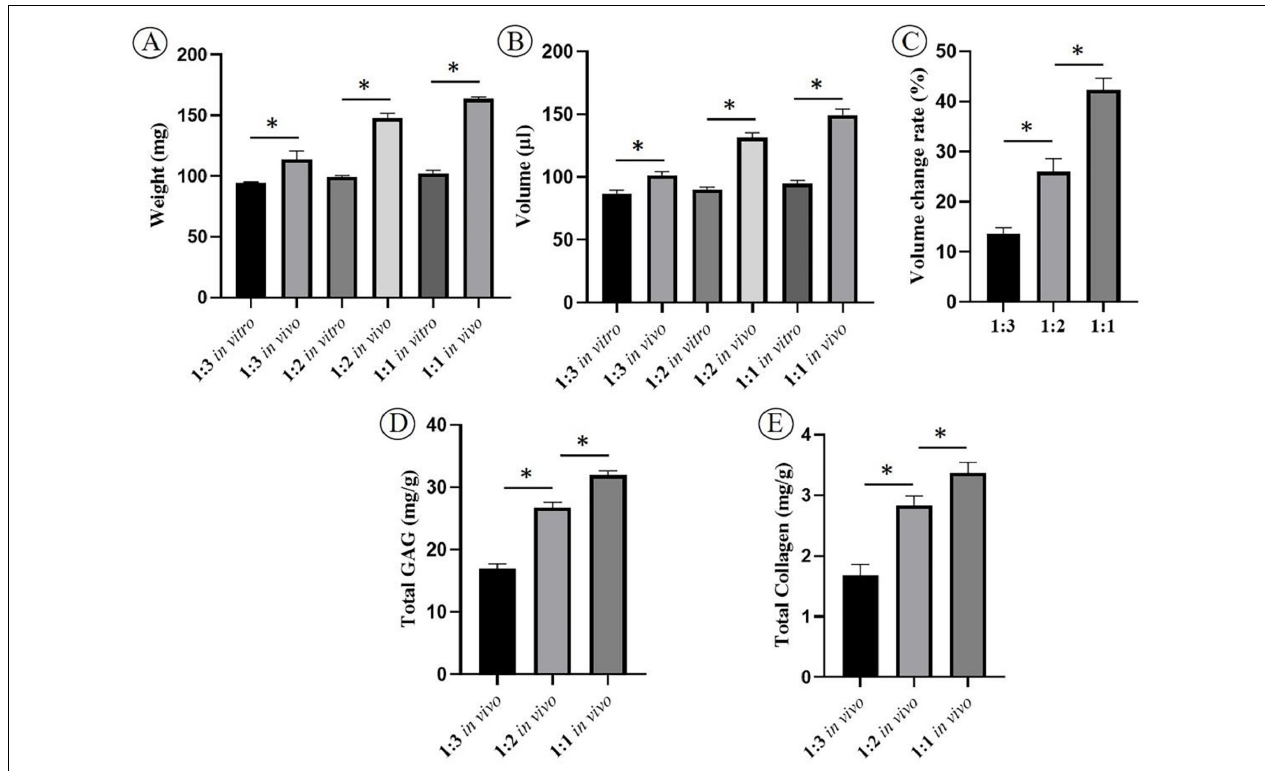
FIGURE 8 | Quantitative evaluations of human engineered cartilage gel–decalcified bone matrix (ECG–DBM) constructs. Quantitative analysis of the wet weight (A) , volume (B) , and volume change rate (C) in different groups after 3-day culture in vitro ( in vitro ) and 12 weeks in vivo ( in vivo ). Total glycosaminoglycan (GAG) (D) and total collagen (E) in different groups after 12 weeks in vivo implantation ( in vivo ). 1:1 = ECG mixed well with onefold medium; 1:2 = ECG mixed well with twofold medium; 1:3 = ECG mixed well with threefold medium. * P <